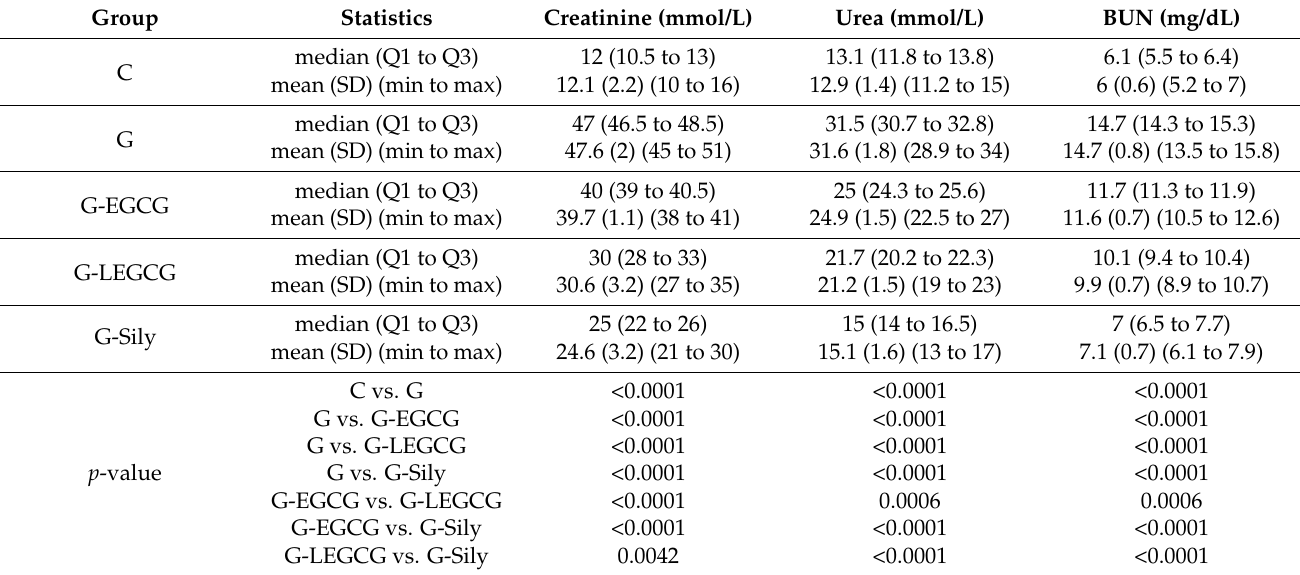
Table 2. Serum markers of renal function by groups after gentamicin administration. The comparative effect of EGCG, LEGCG, and silymarin.